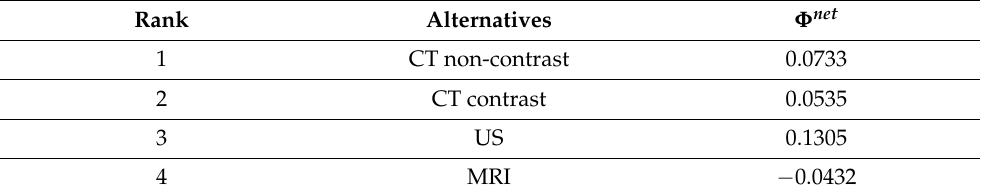
Table 3. Ranking of the acute appendicitis diagnosis for low AIR score by F-PROMETHEE approach.